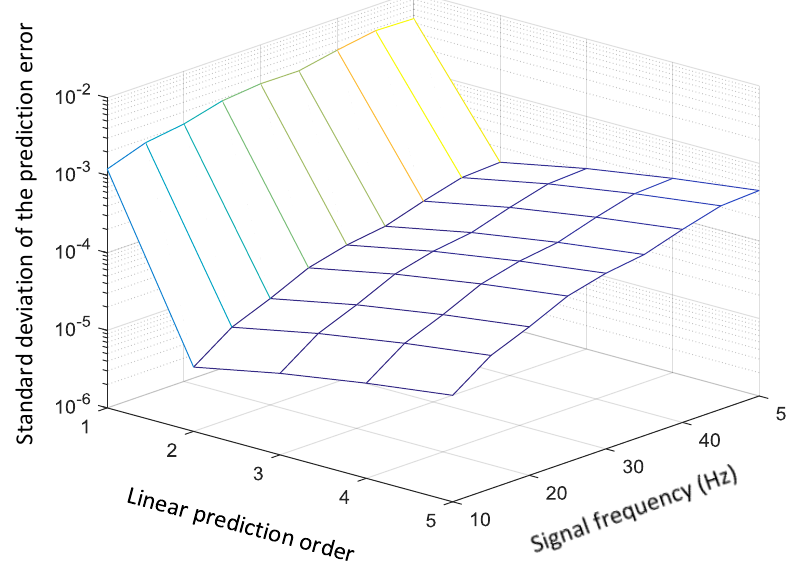
Figure 4. The effect of linear prediction order and signal frequency on prediction error.